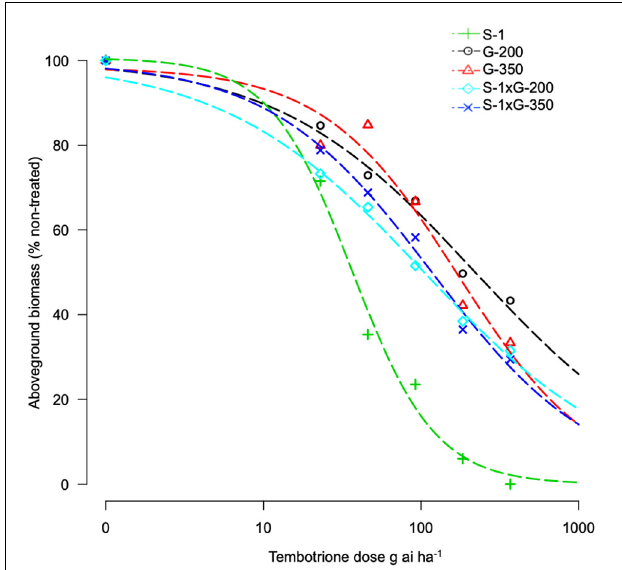
FIGURE 5 | Tembotrione dose-response curves representing the above-ground dry biomass of S-1 (susceptible), F 1 (S-1 × G-200), F 1 (S-1 × G-350), and G-200, G-350 (resistant) using the four-parameter log-logistic